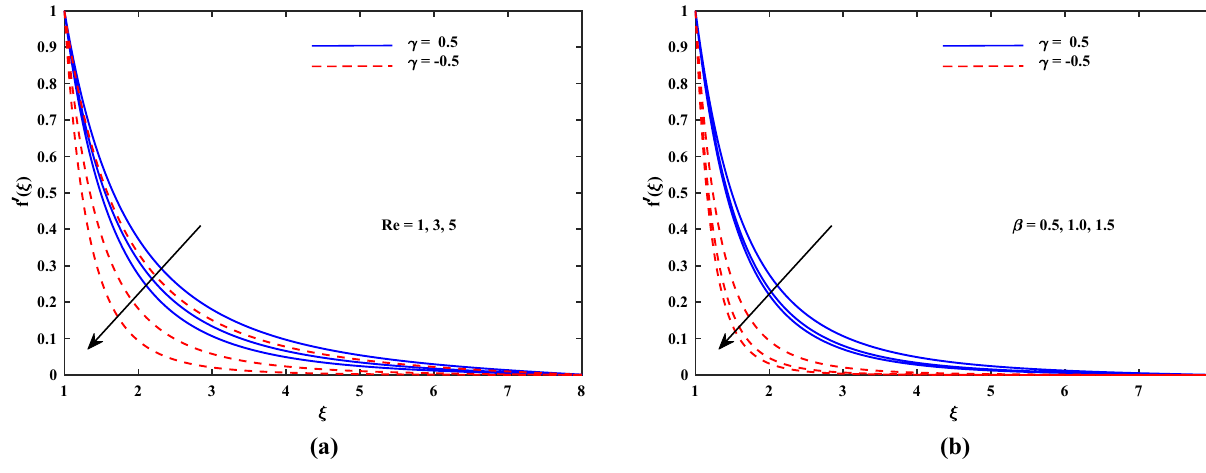
Figure 3. Plot for velocity profile f ′ (ξ) with varying values of Re and β .